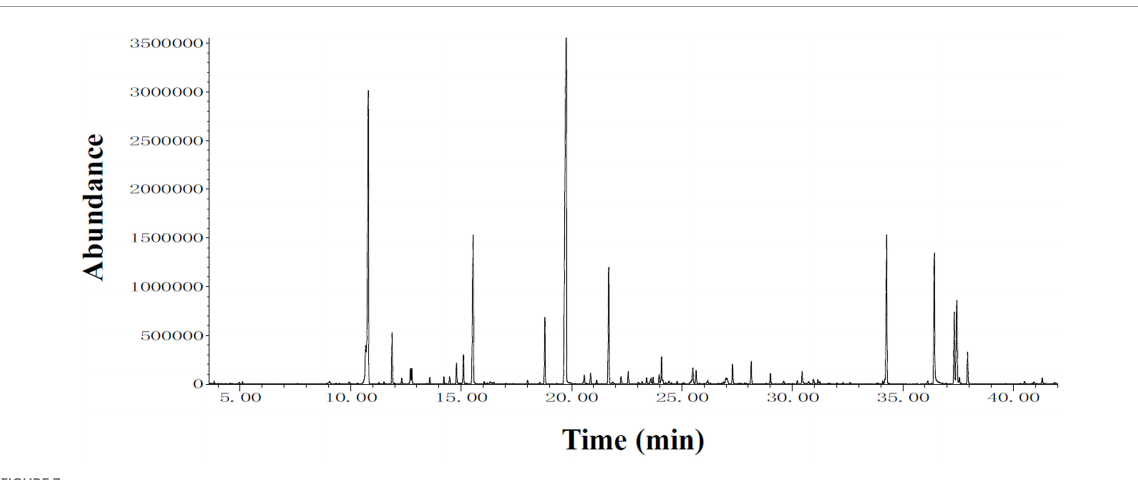
FIGURE7 Chromatograms obtained from GC-MS screening of